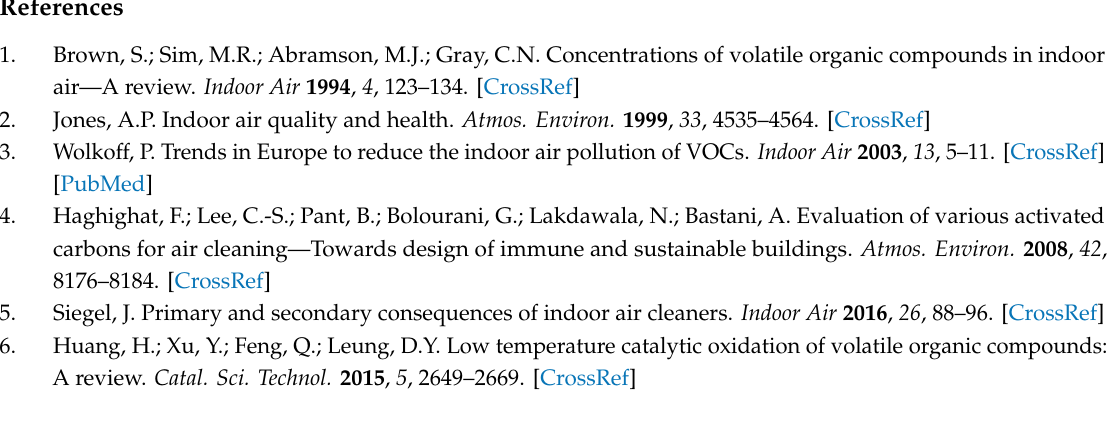
Figure S1: SEM images of BOC ( a ) and BOC-CQD-10 ( b , c ); Figure S2: TEM images of BOC-CQD-15 ( a – d ); Figure S3: XPS spectra of BOC samples: O1s; Figure S4: The CO 2 productivity ( a ), the CO productivity ( b ), the total productivity of CO 2 + CO ( c ), the rate of CO 2 / CO ( d ) of the as-prepared samples for toluene removal in air; Figure S5: The photo images of BOC-CQD-15 under IR, Vis, UV, and full light irradiation during five cycles: before ( a ) and after ( b ).